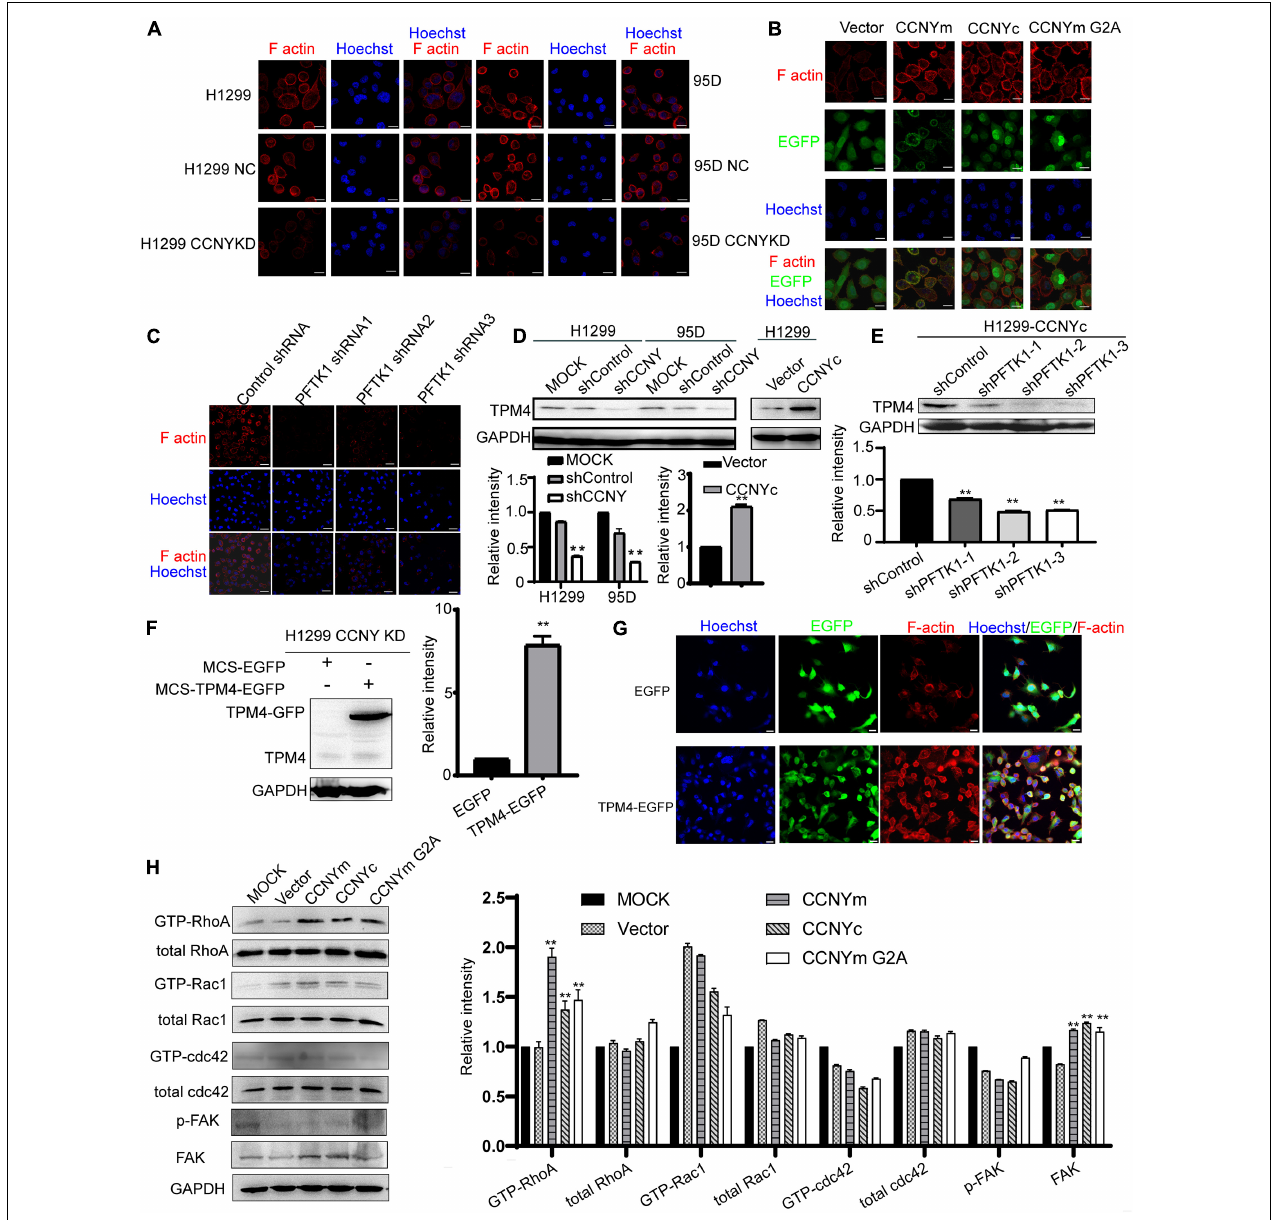
FIGURE 6 | CCNYc/PFTK1 complex promoted the assembly of F-actin via TPM4. (A–C) F-actin was marked by IF staining. Bars represent 20 µ m. (D) Expression level of TPM4 was shown in the figure (upper panel). The quantification of TPM4 level was done by gray analysis (lower panel). ** p < 0.01. (E) TPM4 level in PFTK1 down-regulated H1299 CCNYc cells. Upper panel, the picture of WB, lower panel, the quantification of the TPM4 level. ** p < 0.01 vs. H1299-CCNYc cells expressing control shRNA. (F) TPM4 level was detected by WB. The quantification of TPM4 was shown in the right panel. ** p < 0.01. (G) F-actin was marked by phalloidin conjugating to TRITC. Bars represent 20 µ m. (H) RhoA activity was regulated by CCNY. GTPase activity assay was used to determine the activated level of (GTP-) Rac1, RhoA, and Cdc42. The phosphorylated FAK on Y397, as well as the FAK level, were examined by immunoblotting. The protein levels were quantified by gray analysis and showed in the right panel. ** p < 0.01 vs. H1299 cells transfected with pEGFP-N1